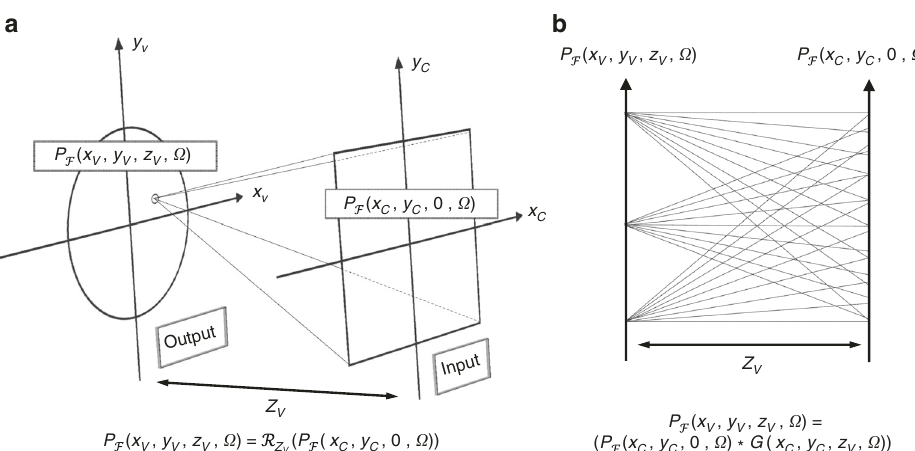
Fig. 2 Rayleigh Sommerfeld Diffraction (RSD) calculation. a Two parallel planes geometrical setup for the reconstruction. The input and output planes are space with z v . b Side view for a